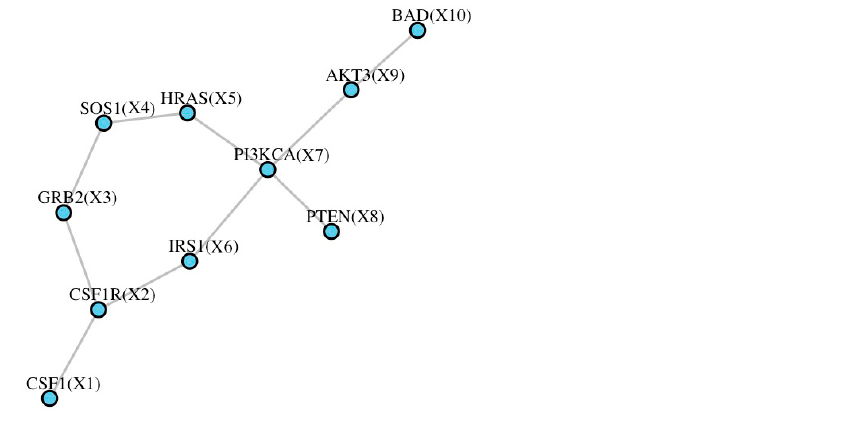
Figure 1. The simulated network for the PI3K-AKT signaling pathway from KEGG.